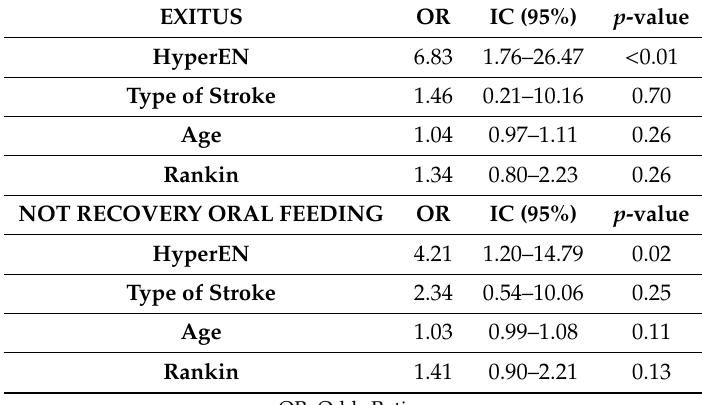
Table 2. Relationship of hyperglycaemia associated with enteral nutrition (HyperEN) with death and recovery of the oral feeding on the type of stroke, age, and Rankin scale.